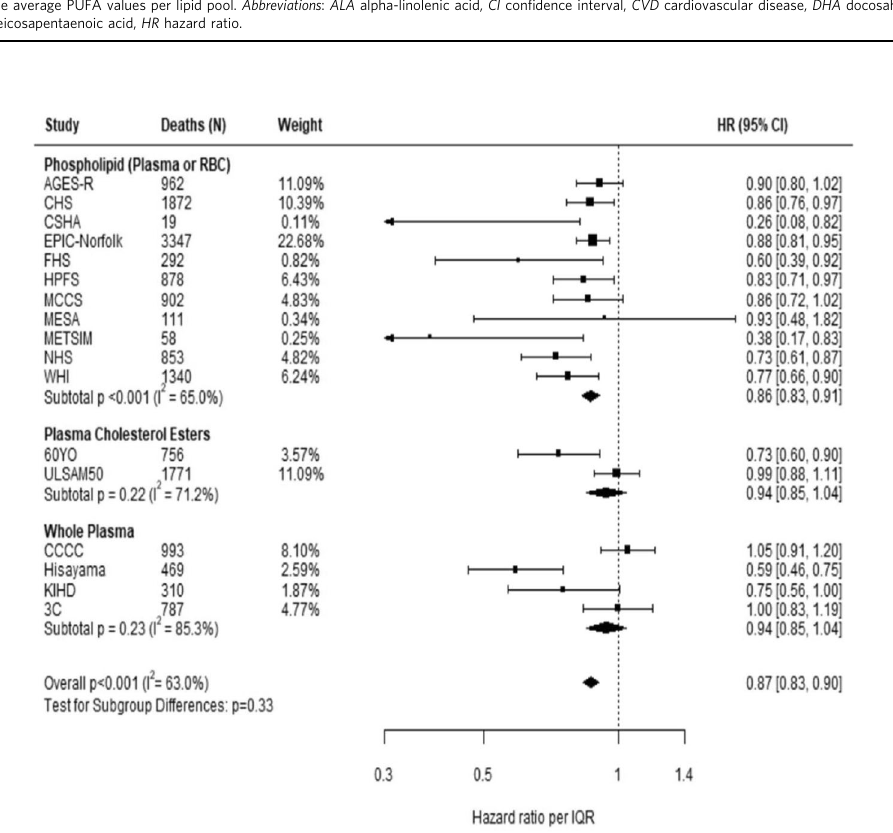
Fig. 1 Adjusted hazard ratios (HR, 95% CI) for total mortality for circulating eicosapentaenoic (EPA) plus docosahexaenoic acid (DHA) in the 17 contributing studies of the Fatty Acids and Outcomes Research Consortium. Study-speci fi c estimates for HRs (dark squares) are shown per interquartile range (comparing the midpoint of the top to the bottom quintiles) their sizes indicate study weights (column 3). The horizontal line through each HR is 95% CI. Compartments included erythrocyte phospholipids, plasma phospholipids, cholesteryl esters, and total plasma. All HRs are adjusted for age, sex, race, fi eld center, body-mass index, education, occupation, marital status, smoking, physical activity, alcohol intake, prevalent diabetes, hypertension, and dyslipidemia, self-reported general health, and the sum of circulating n-6 PUFA (linoleic plus arachidonic acids). See Table 1 footnote for abbreviations of